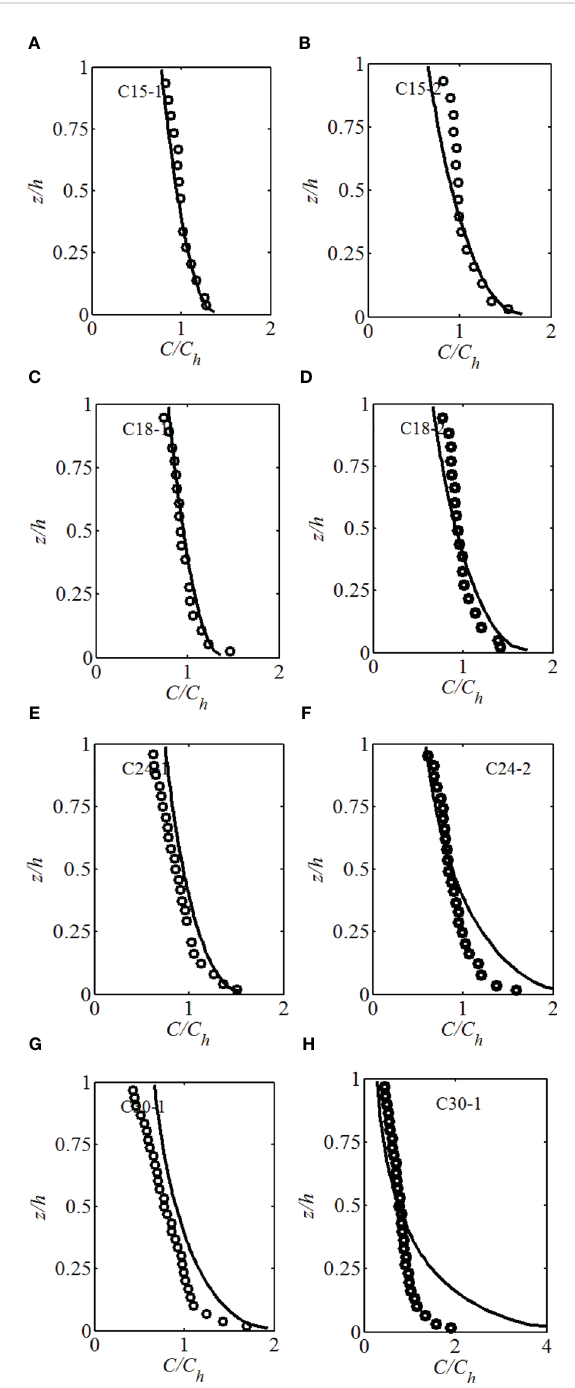
FIGURE 9 Comparisons of measured and simulated sediment concentrations normalized by the concentrations at cylinder top (C h ) in tests carried out by Lu (2008): (A) C15-1, (B) C15-2, (C) C18-1, (D) C18-2, (E) C24-1, (F) C24-2, (G) C30-1, (H) growing wave height, especially near the bottom. In the upper layer ( z >0.2m), there were clear deviations between the measured and simulated data. The sediment concentration near the bottom was mainly controlled by the bottom sediment fl ux, while it was determined by turbulent diffusivity in the upper layer.